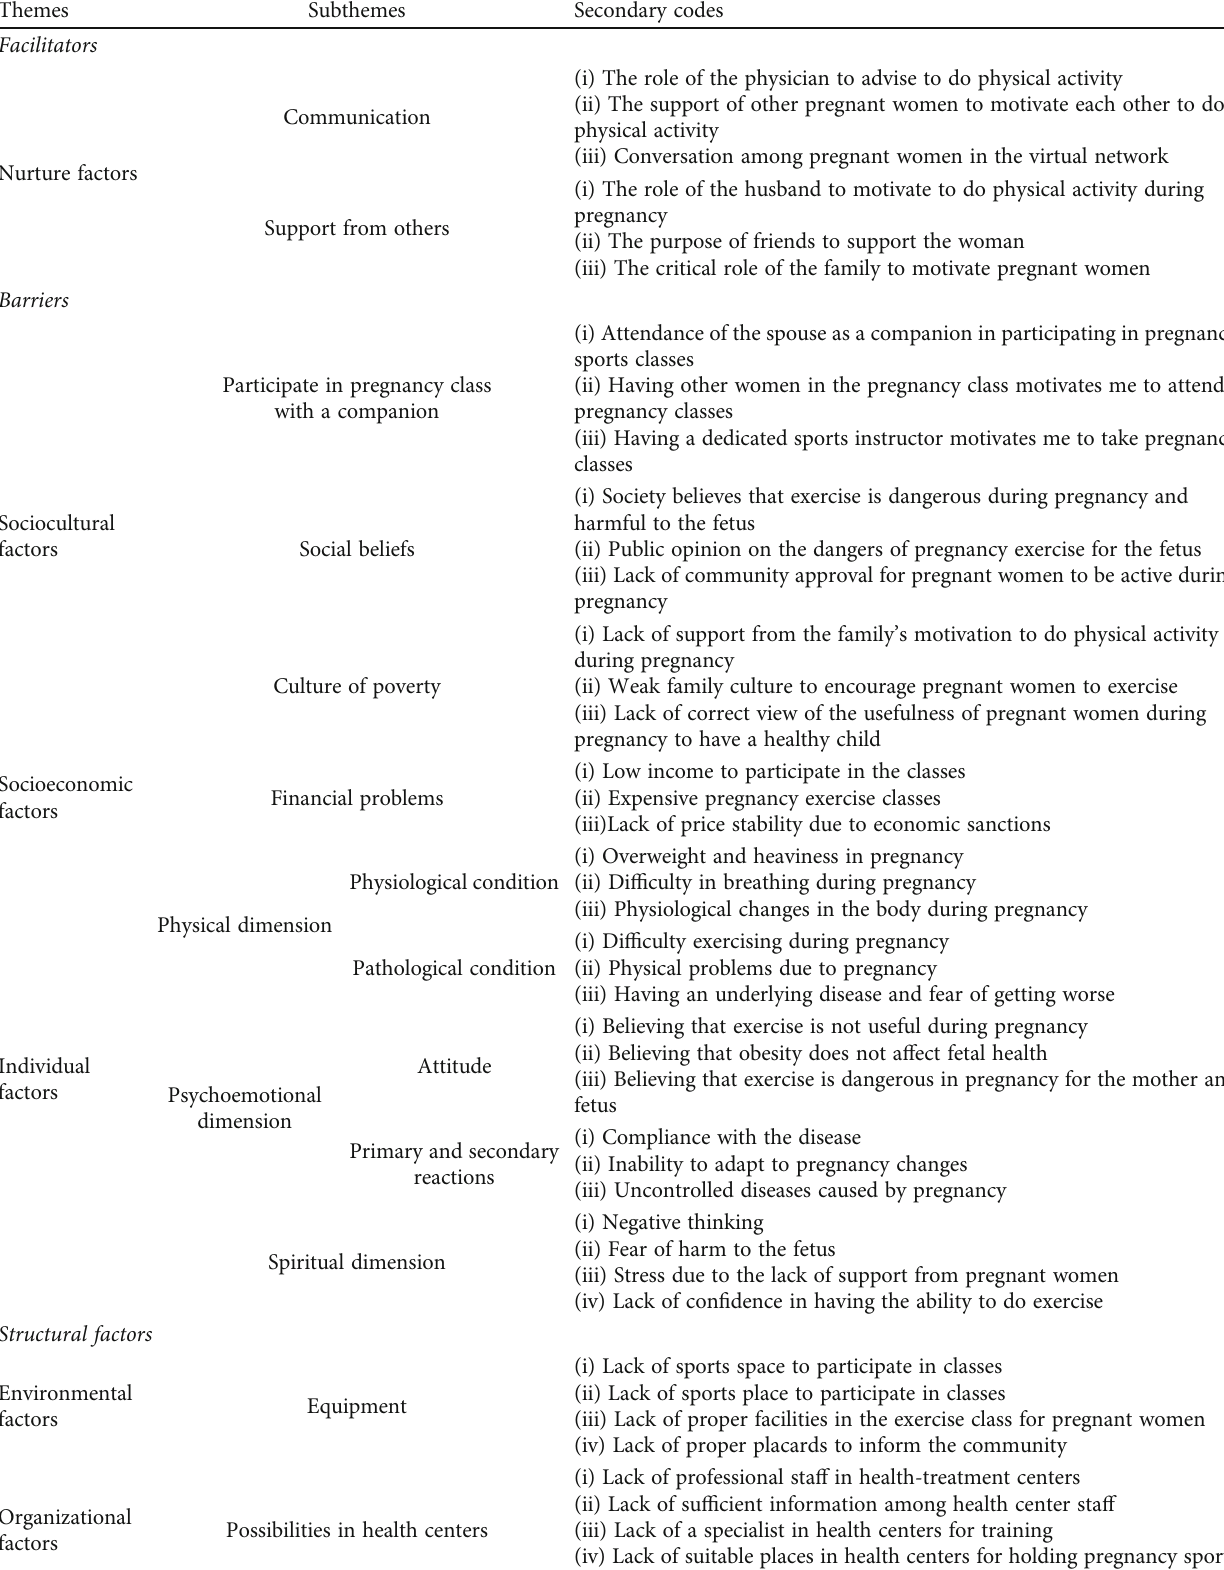
Table 2: The theme, subthemes, and codes of the facilitators, barriers, and structural